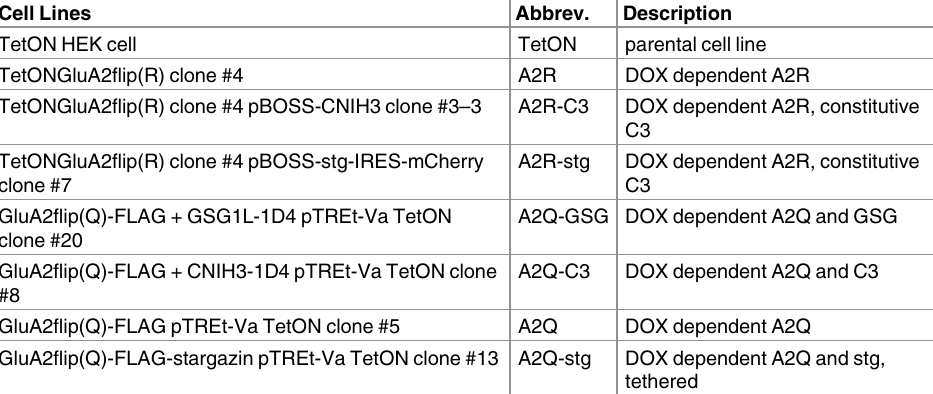
Table 1. Summary of cell lines used for